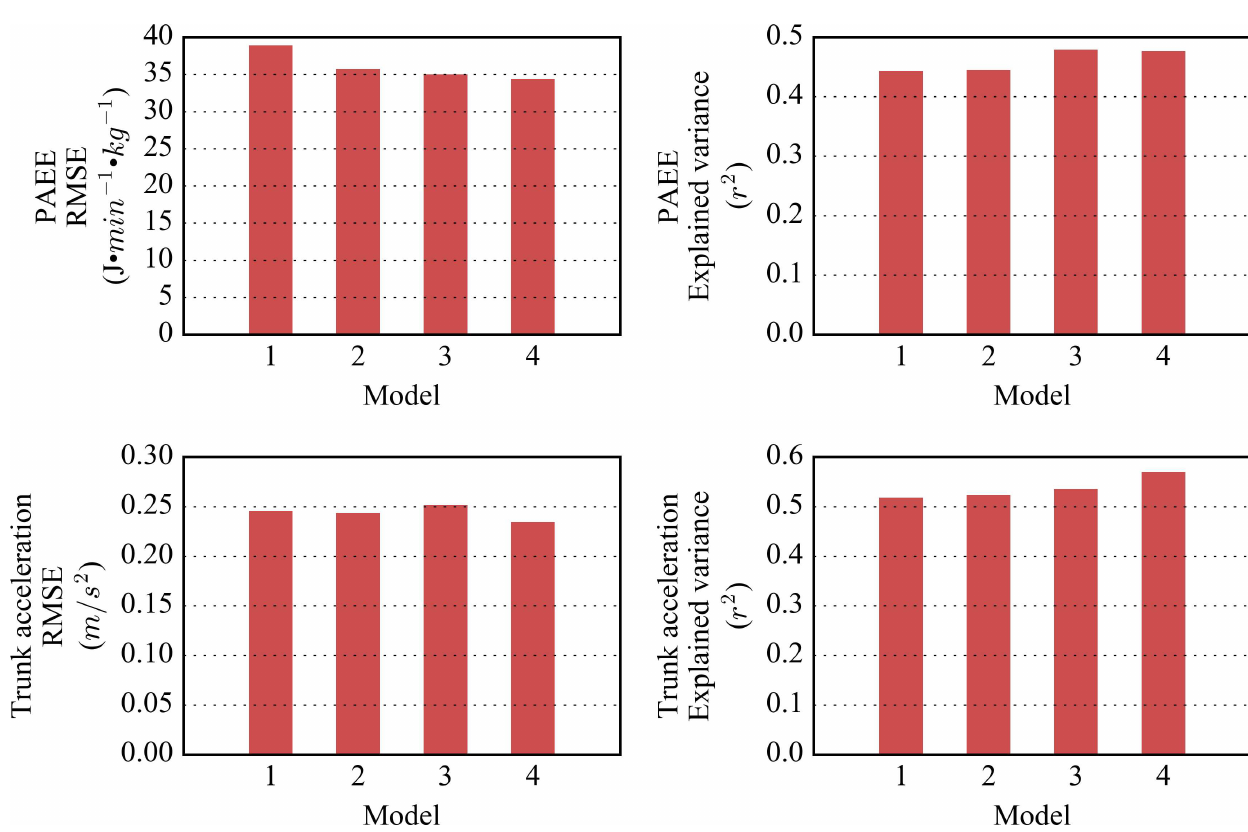
Fig 2. Performance of the four models of wrist acceleration. Explained variance shown is between-individualexplainedvariancefrom ANOVA